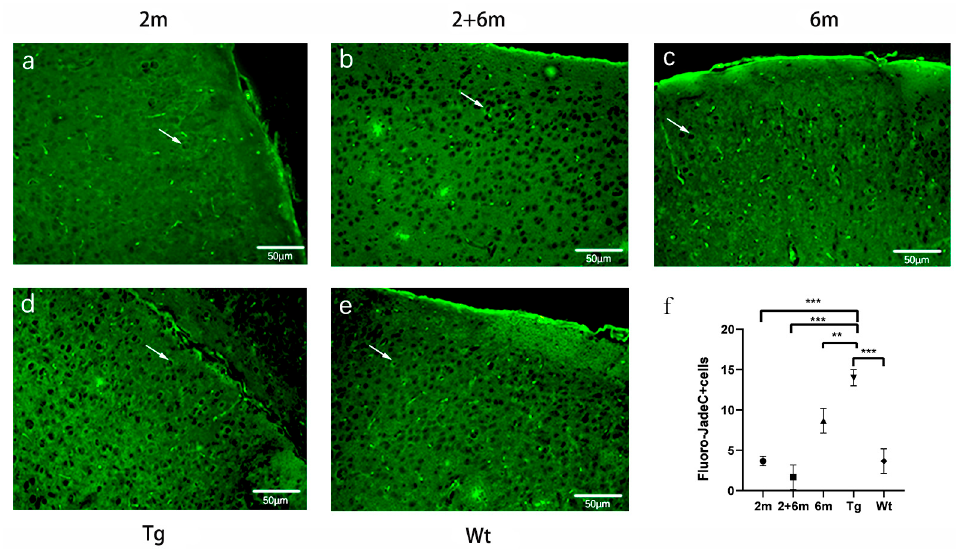
Figure 4. BG45 alleviated neuronal degeneration in the entorhinal cortexes of the APP/PS1 mice. ( a – e ) The positive FJC-stained cells were stained green (white arrows) in the entorhinal cortex region. ( f ) Quantitative statistical analysis of the FJC-positive cells. Scale bar = 50 µ m. All values are presented as the means ± SDs from three independent experiments. *** p < 0.001 and ** p < 0.01. n = five mice per group.